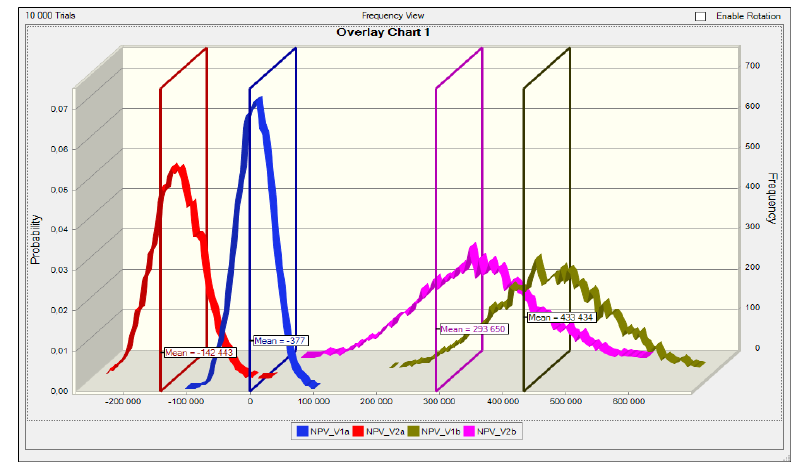
Figure 8. Probability distributions of NPV versions of investment variants.